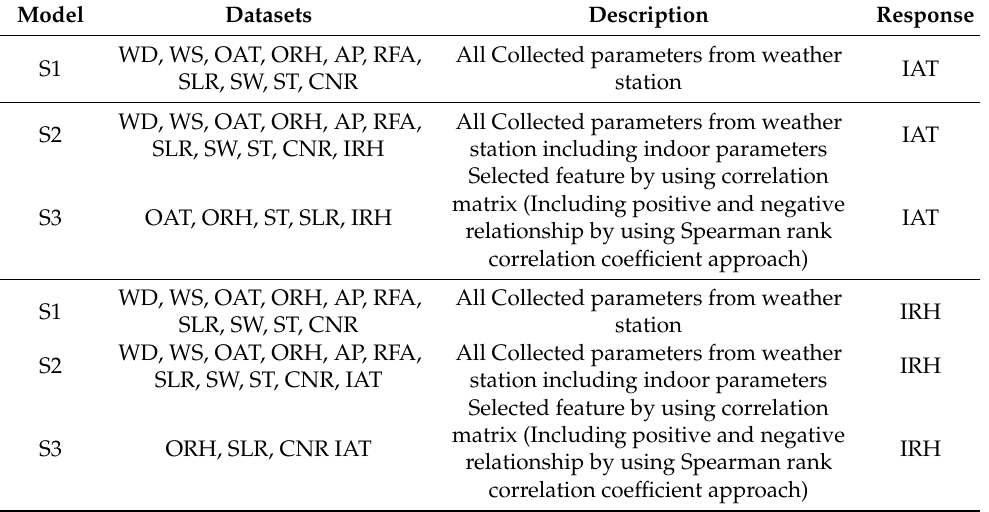
Table 2. Summary of the attributes which were chosen to train the model named S1, S2, and S3 during IAT and IRH